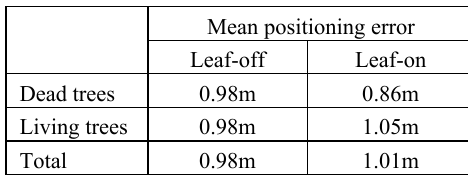
Table 8. Accuracy of the tree position